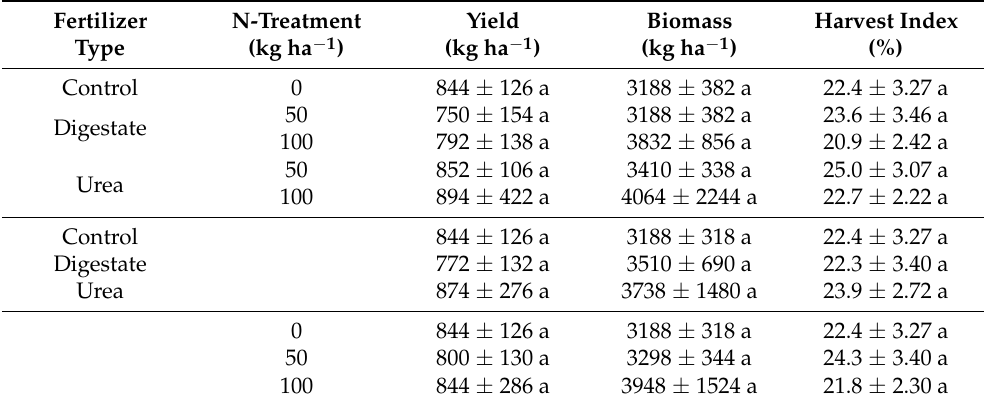
Table 2. ANOVA test ( ± Standard Deviation) for seed yield (kg ha − 1 ), aboveground biomass (kg ha − 1 ), and harvest index.